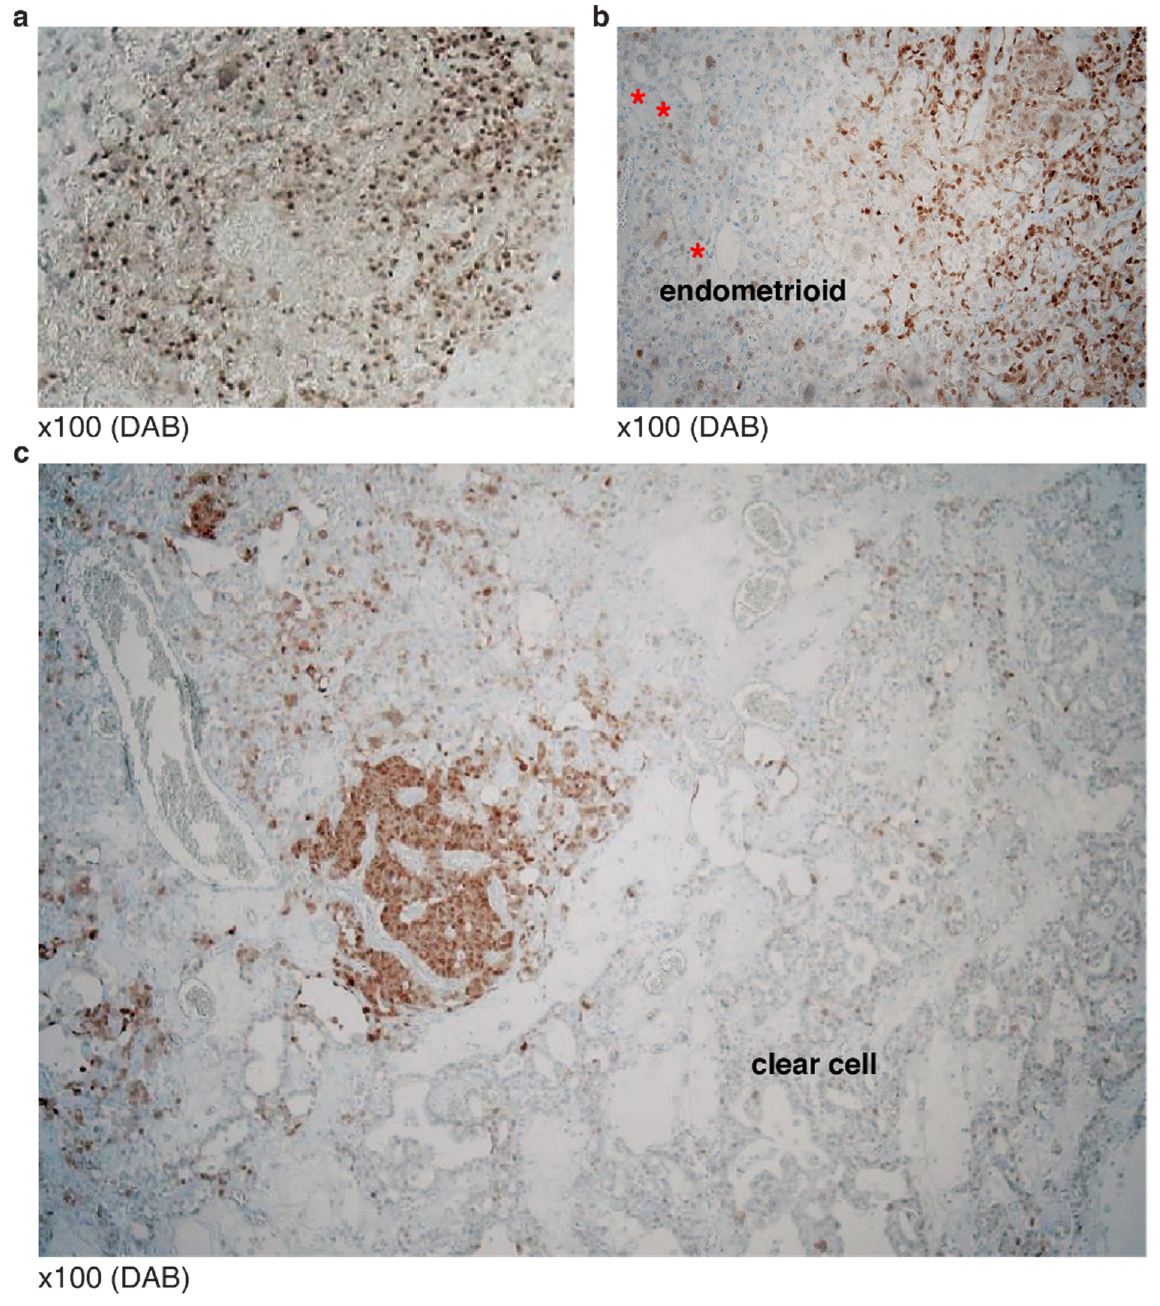
Figure 7. P53 mosaic staining patterns in mixed carcinoma: ( a ) Composite carcinoma including serous carcinoma; ( b ) endometrioid carcinoma with serous carcinoma, p53 poorly stained. Red asterisks: simple tubular structures often seen in endometrioid carcinoma; ( c ) mixed clear cell type with a WT pattern of p53, surrounding serous carcinoma showing diffuse staining.